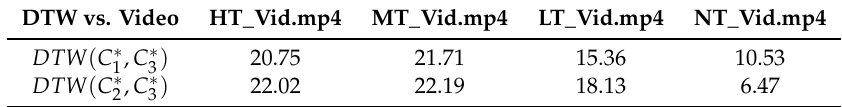
Table 3. Omnidirectional traffic curve comparison: C ∗ Count (ground